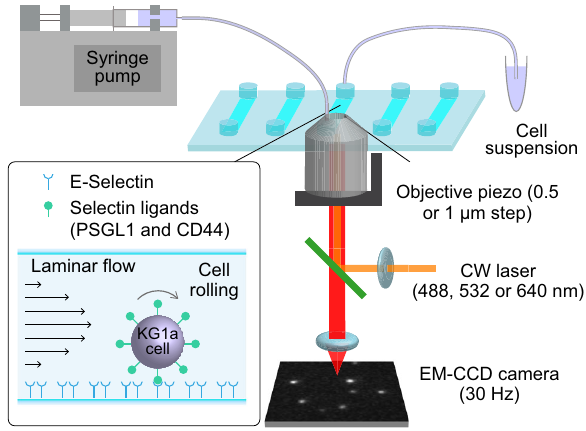
Fig. 1 Experimental con fi guration. Schematic illustration describing the custom-built micro fl uidics-based single-molecule imaging